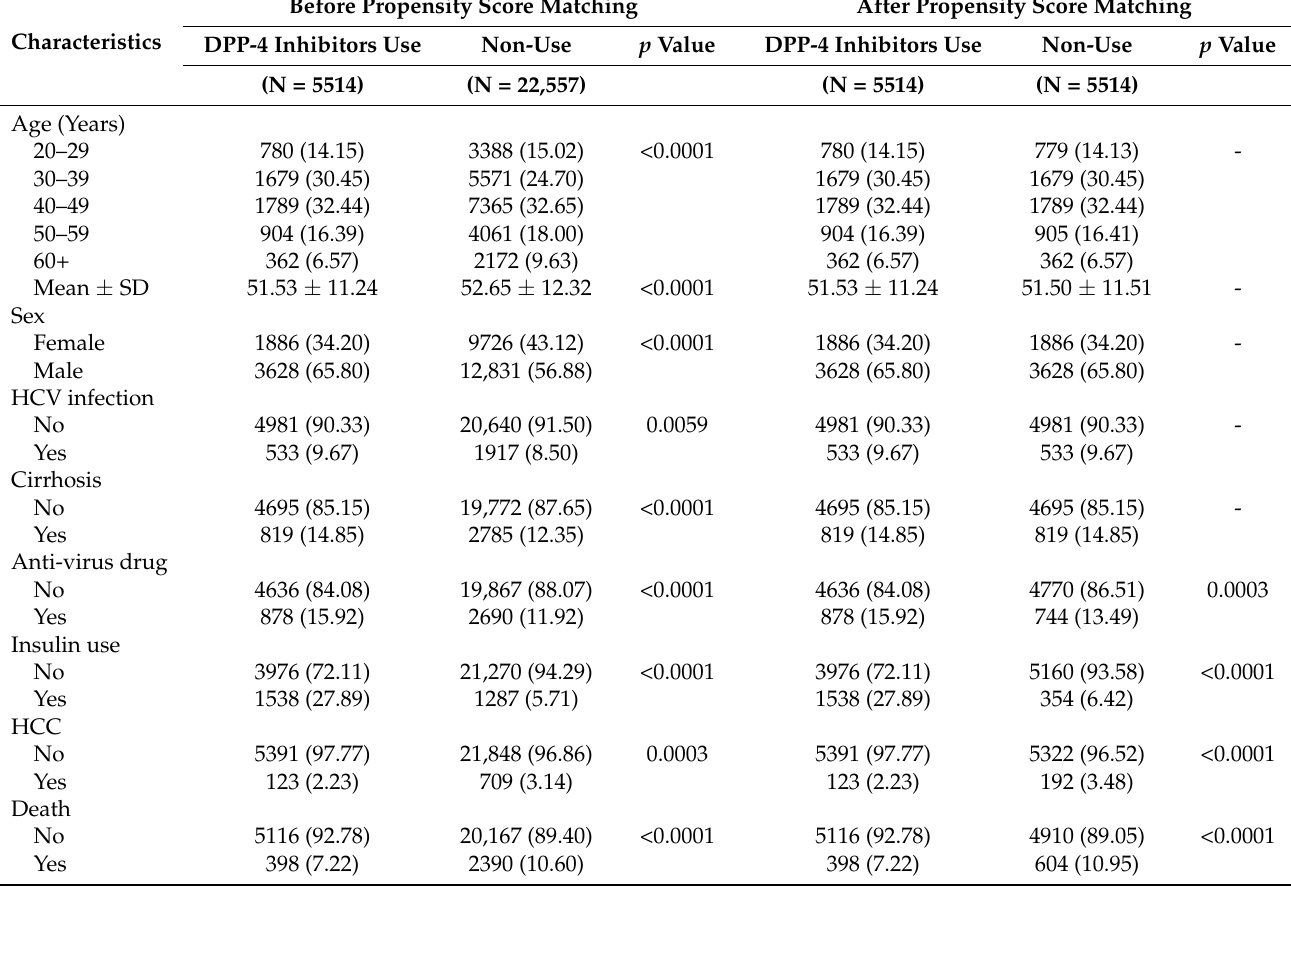
Table 1. Baseline characteristics of the study population, stratified by the use of DPP-4 inhibitors before and after propensity score match.